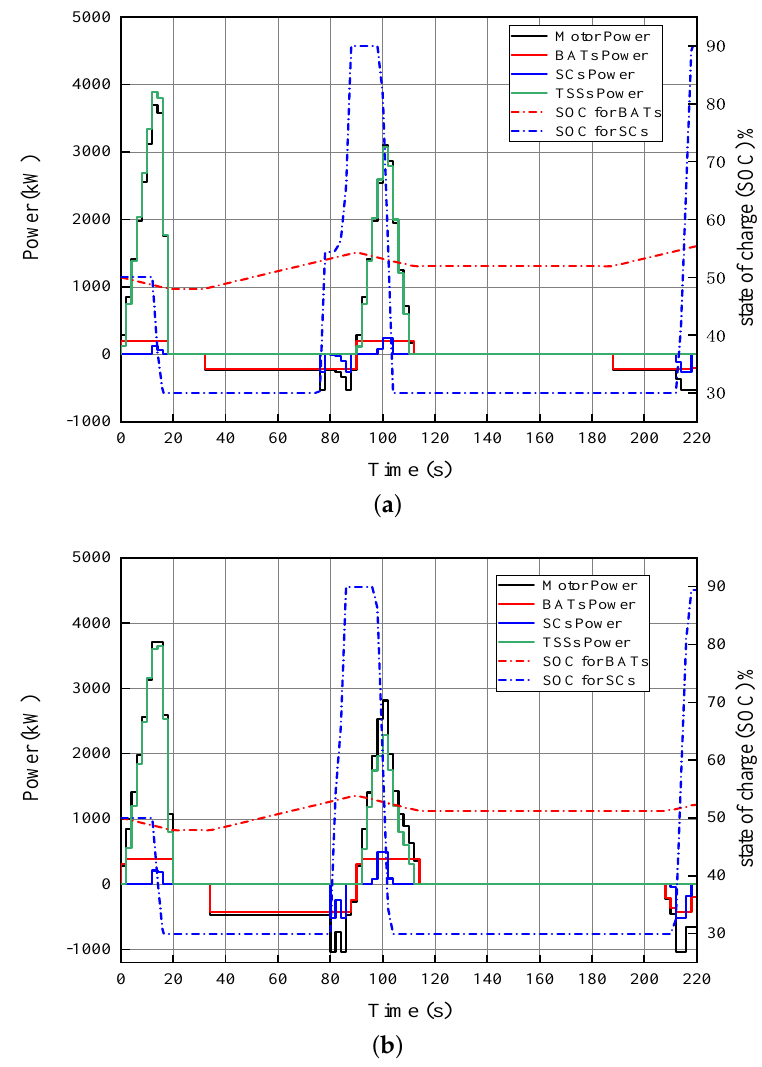
Figure 6. The motor power, TSSs power, discharge/charge power of on-board HESDs and SOC curves for cases 2–3. ( a ) case 2. ( b ) case